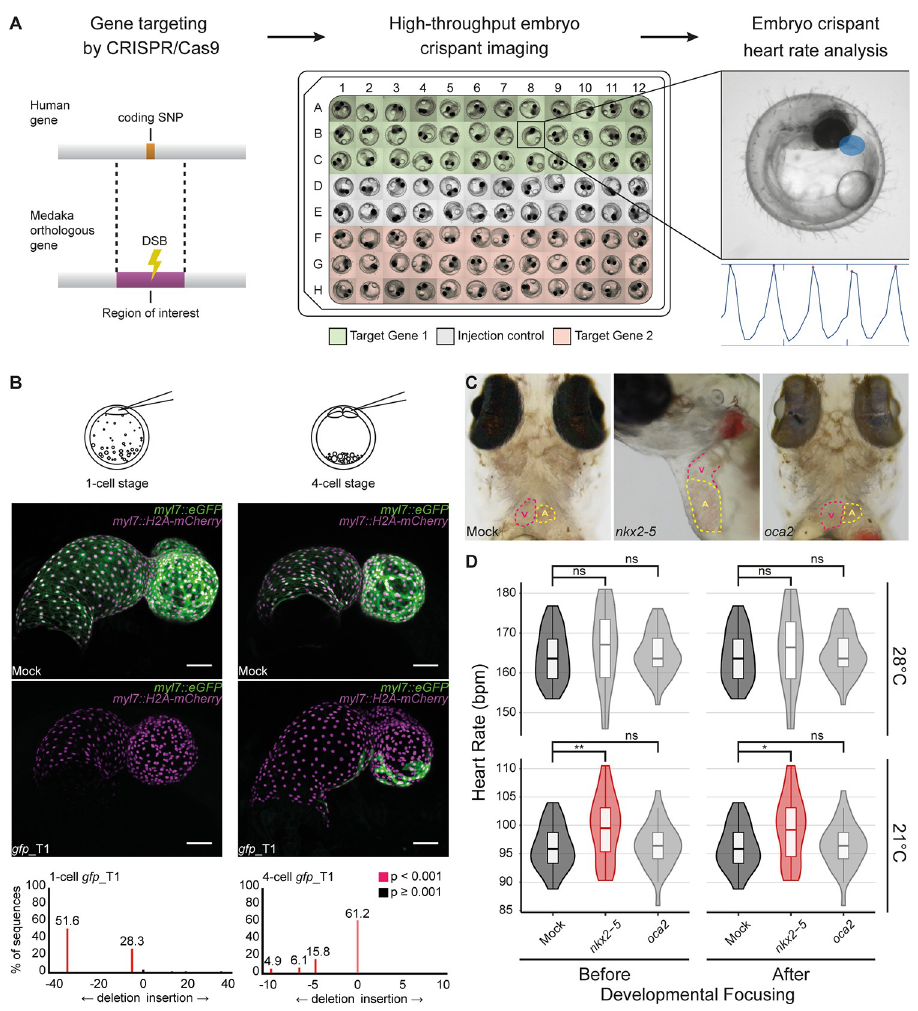
Fig 1. Functional gene validation pipeline confirms heart rate phenotype in nkx2-5 crispants. (A) Schematic overview of our functional gene validation pipeline: position of human coding SNP mapped to medaka orthologous gene to define region of interest for CRISPR/Cas9 gene targeting (double strand break; DSB). 96-well plate layout of crispant embryos (Target Gene 1 and 2) separated by GFP mRNA mock-injected siblings. Embryos are subjected to high-throughput imaging followed by automated heart detection (blue area) and heart rate quantification (graphical output; HeartBeat software [26]. (B) Confocal images (mirrored) of GFP expression in mock-injected and gfp crispant embryo hearts of the myl7 :: eGFP myl7 :: H2A-mCherry reporter line (7 dpf). Embryos were injected either at the 1-cell or 4-cell stage. Note: complete loss of GFP expression when injected at the 1-cell stage (n = 8/8), while mosaic expression when injected at 4-cell stage (n = 4/4). Genotyping of gfp crispants display the genetic mosaicism resulting from Cas9-based targeting. Scale bars: 50 μ m. For full image refer to S1 Fig. (C) Comparison of the atrium (A, dotted red line) and ventricle (V, dotted yellow line) in GFP -injected (Mock) and nkx2-5 and oca2 crispant embryos (9 dpf). Note: nkx2-5 crispant shows dilated heart chambers while mock injected and oca2 crispant embryos are indistinguishable. Loss of eye pigmentation in oca2 crispants reflects high efficiency of knock-out rate in the injected generation. (D) Heart rate measurements (beats per minute, bpm) of GFP -injected (Mock; dark grey), nkx2-5 and oca2 crispant embryos (4 dpf) at 21 and 28˚C, before (left) and after (right) exclusion of severely affected embryos (developmental focusing) reveal elevation of mean heart rates in nkx2-5 targeted embryos, significant at 21˚C (red). Significance was determined by two-tailed Student’s t-test; � p < 0.05, �� p < 0.01, ns (not significant; light grey). For biological replicates see Source Data Fig 1D in S1